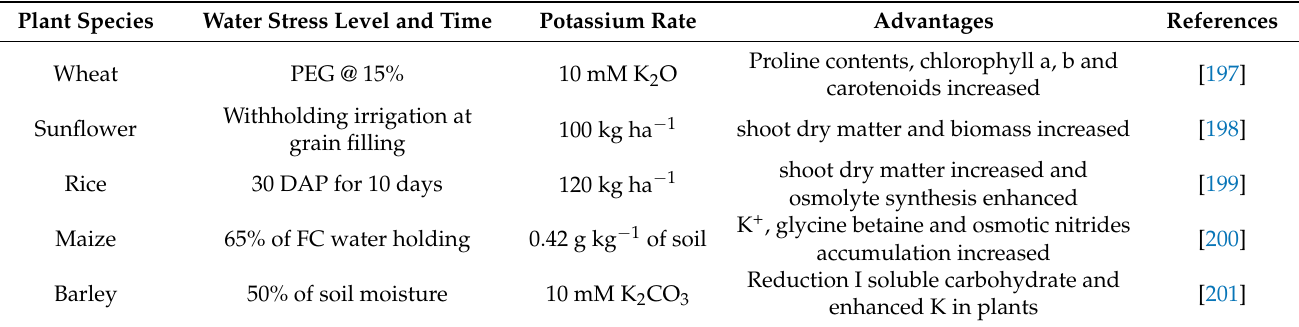
Table 6. Potassium application mitigates the adverse effects in plants subjected to water deficit stress.